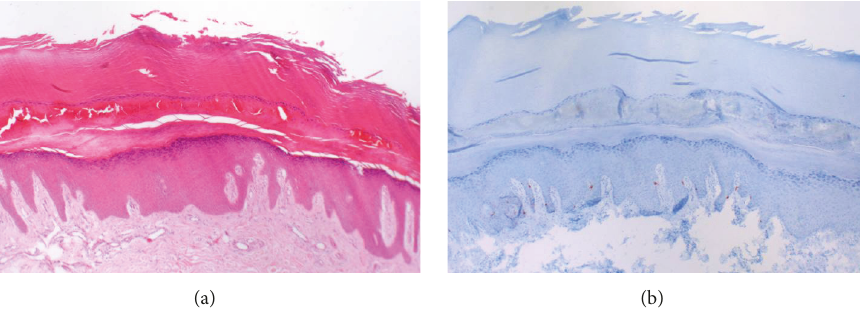
Figure 2: Histopathology (a) and immunohistochemistry (b) of the surgically removed skin alteration (original magnification × 40). Hematoxylin and eosin stain shows thickened orthokeratosis typical for acral skin, sampled stratum corneum with parakeratosis, serosanguinous fluid, and degenerated erythrocytes (a). Immunohistochemical stain for Melan-A revealed regular distribution of basal melanocytes without evidence of malignancy